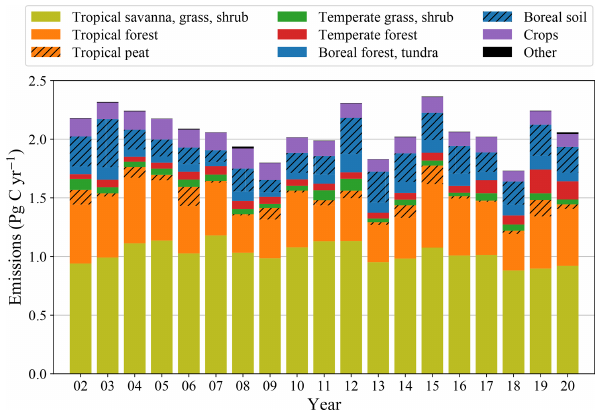
Figure 6. Global annual emissions for 2002–2020 based on the 500m model. Bars are subdivided into biomes, with belowground emissions in two separate classes (tropical peat and boreal